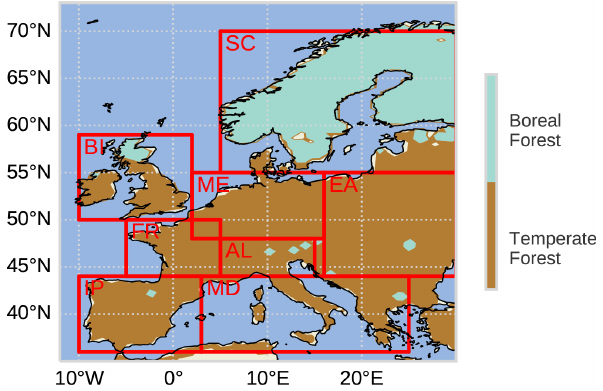
Figure 1. Spatial distribution of boreal and temperate forests in the CCLM-VEG3D FOREST and CARBON